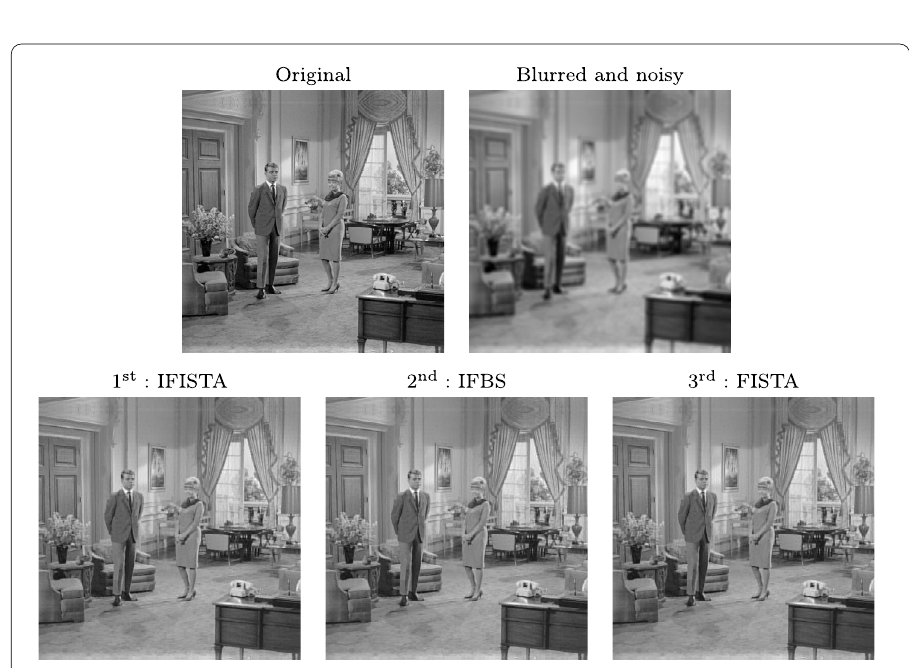
Figure 8 Top three fast processing with high performance for deblurring of Living